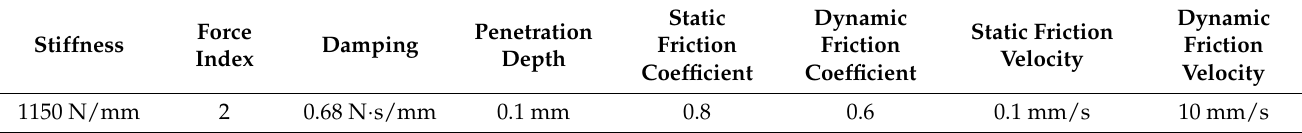
Table 3. Contact parameters for assessing walking and turning.